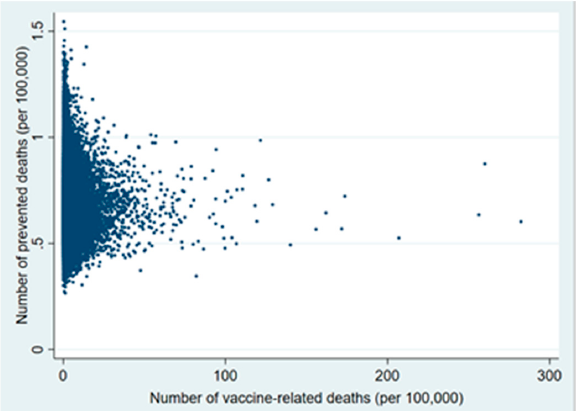
Figure 3. Probabilistic sensitivity analysis. Number of vaccine-prevented deaths for COVID-19 (benefit) vs. vaccine-related deaths for thrombo-embolic events (risk) after 100,000 simulations. Individuals aged 50–59 years, Italy.